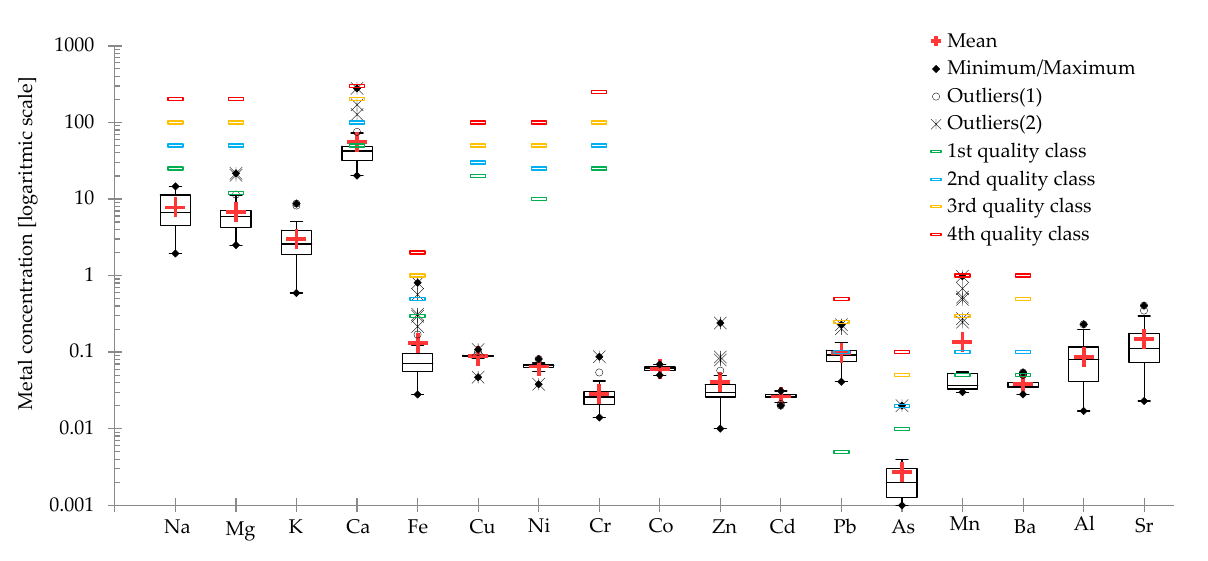
Figure 3. The variation of elements in the sampling sites.